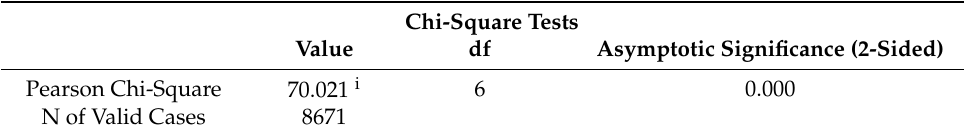
Table 23. Chi-square test (enterprise size vs. change in the ROS 2021 profitability indicator). Source: own research.